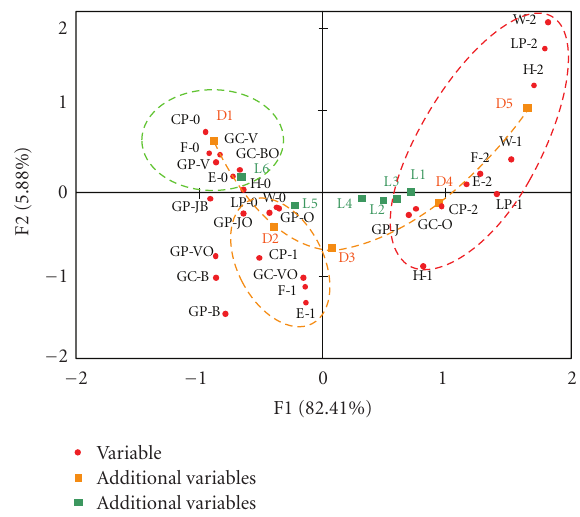
Figure 4: Result, in terms of the first two factorial axes, of the mul- tiple correspondence analysis carried out on the table [individuals × variable pigment]. Ellipses surround variables characteristic of the solitary, solitaro-transiens/transiens, and gregarious populations. The brown individuals, from dubious status, isolate themselves on axis 3. Codification of the variables (red dots): (1) variables related to the black pigmentation (0, 1 or 2 according to the melanisation intensity): compound eye (E), cephalic capsule (H), median carina of pronotum (CP), wings rudiments (W); lateral black spot of pronotum (LP), black spot on hind femur (F); (2) variables related to the general color of the tegument (V, green; B, brown; O, orange; J, yellow): cephalic capsule (GC) and pronotum (GP). Variables introduced into the MCA as additional elements: D1 to D5, density of the hopper population (D1 < 10, D2 = [10–30], D3 = [30–70], D4 = [70–100], D5 > 100 / m 2 ) (orange squares); L1 to L6, hopper instars (green squares).